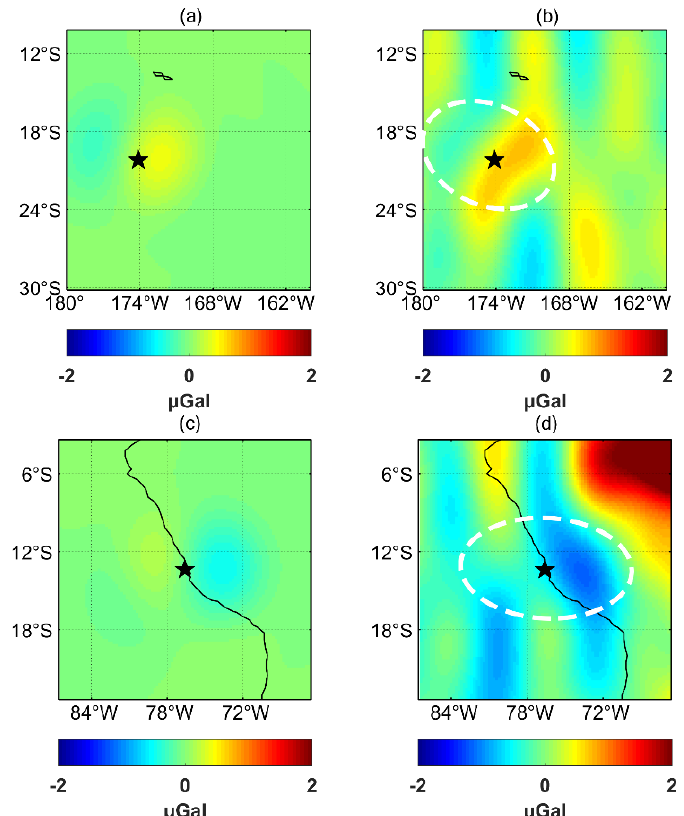
Figure 8. Coseismic gravity change in the 2006 Mw8.0 Tonga and 2007 Mw8.0 Peru earthquake region, respectively. ( a ) The dislocation model prediction of 2006 Mw8.0 Tonga. ( b ) Coseismic gravity changes by stacking method in the 2006 Mw8.0 Tonga region. ( c ) The prediction of 2007 Mw8.0 Peru. ( d ) Coseismic gravity changes in Peru region. The white dotted lines represent “similar coseismic signals”.